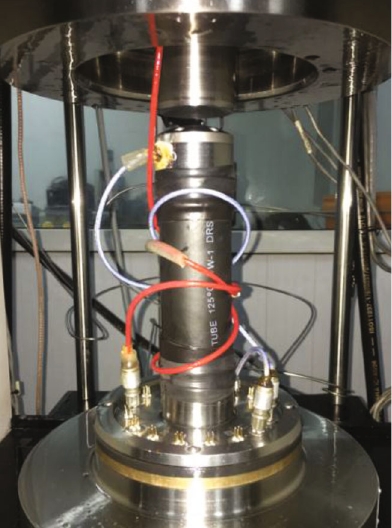
Figure 3: Permeability experimental